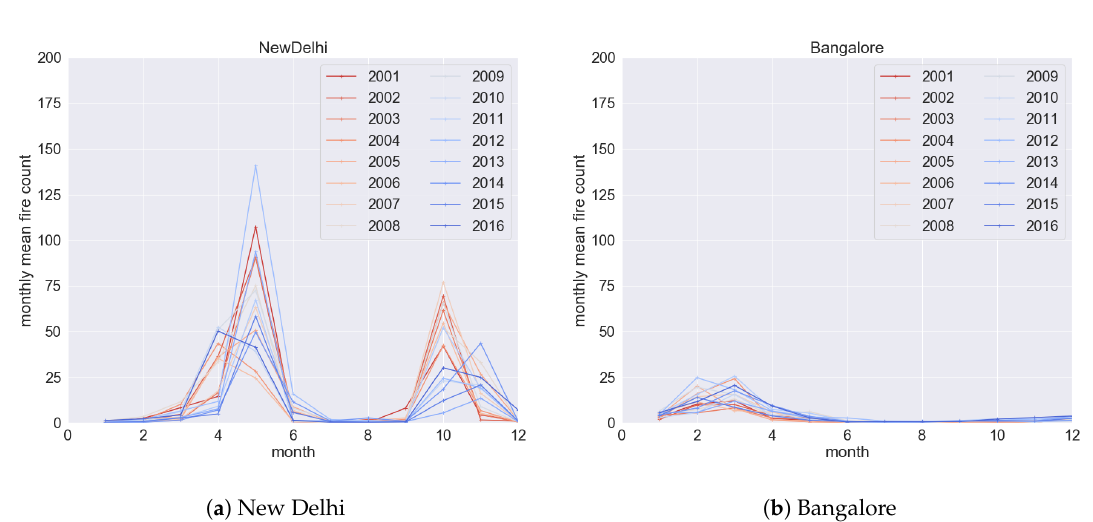
Figure 4. Monthly mean of daily fire counts are much higher around cities in northern India (New Delhi ( a )) than the cities in southern India (Bangalore ( b